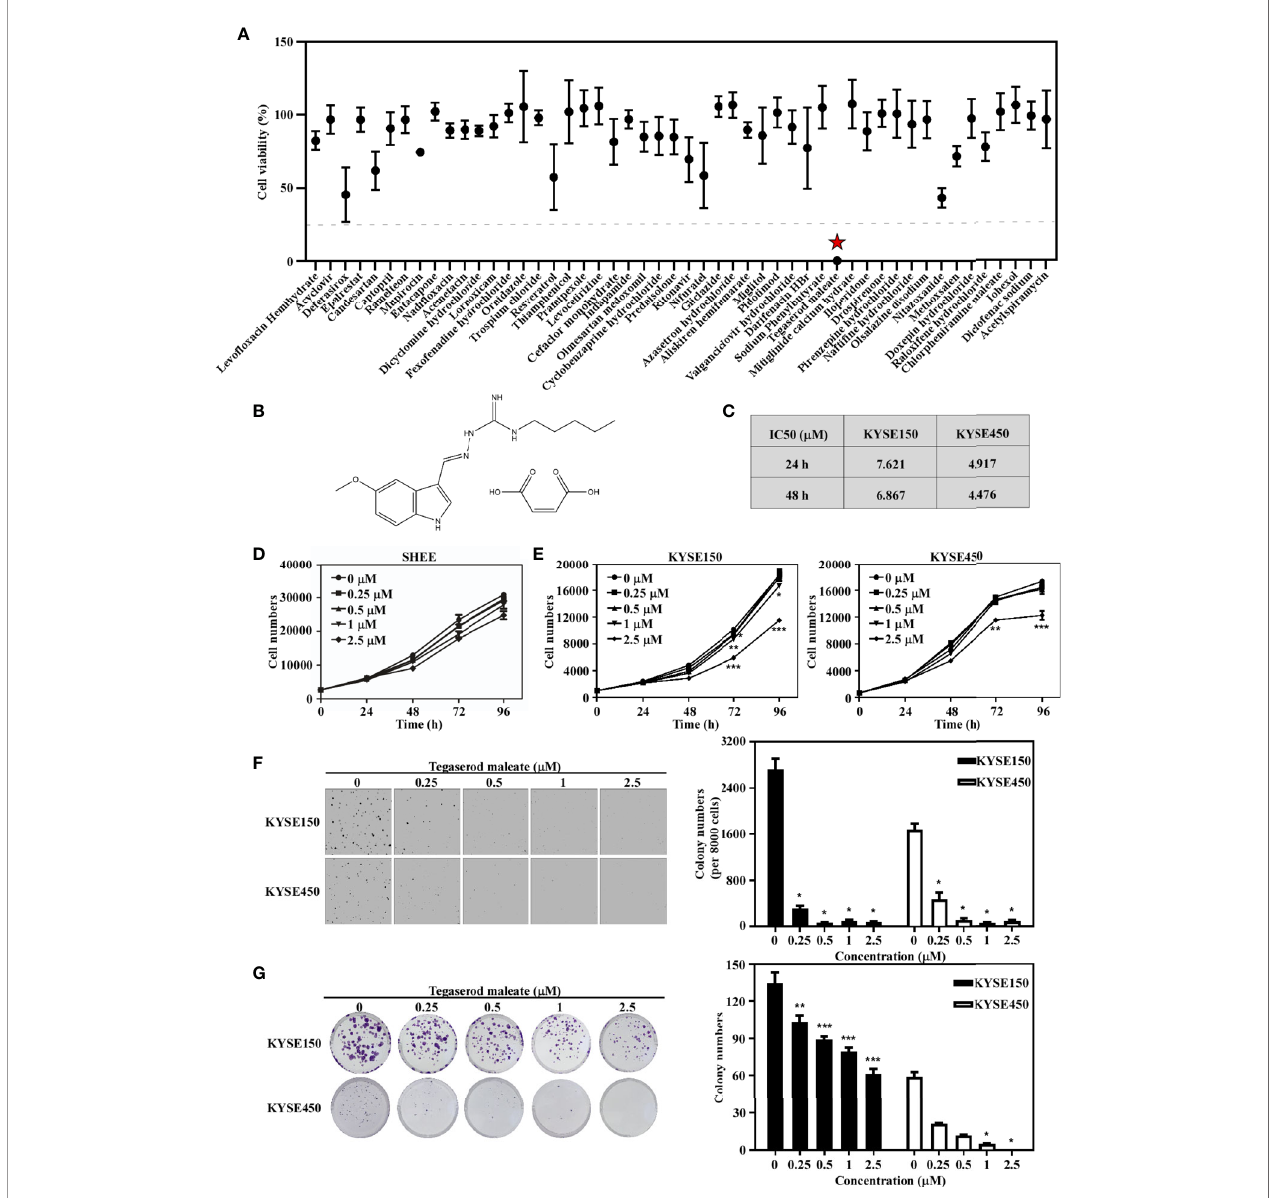
FIGURE 1 | Tegaserod maleate inhibits ESCC cells proliferation in vitro . (A) A cell viability screening identi fi ed tegaserod maleate has anti-esophageal cancer activity among the FDA approved compounds. (B) The chemical structure of tegaserod maleate. (C) The different IC 50 values of KYSE150, KYSE450 according to the cytotoxicity assay. (D) The effect of tegaserod maleate on immortalized human esophageal epithelial cell line SHEE cells viability. (E) KYSE150 cells (left panel) and KYSE450 cells (right panel) were treated with different concentrations of tegaserod maleate (0, 0.25, 0.5, 1.0 and 2.5 µM). Tegaserod maleate effectively suppresses anchorage-independent cell growth (F) and plate colony formation (G) . Left panel: the representative pictures of clones. Right panel: the statistic of colony numbers (n = 3). Data was shown with mean ± SD. (* p < 0.05, ** p < 0.01, *** p < 0.001 vs. untreated control, n ≥